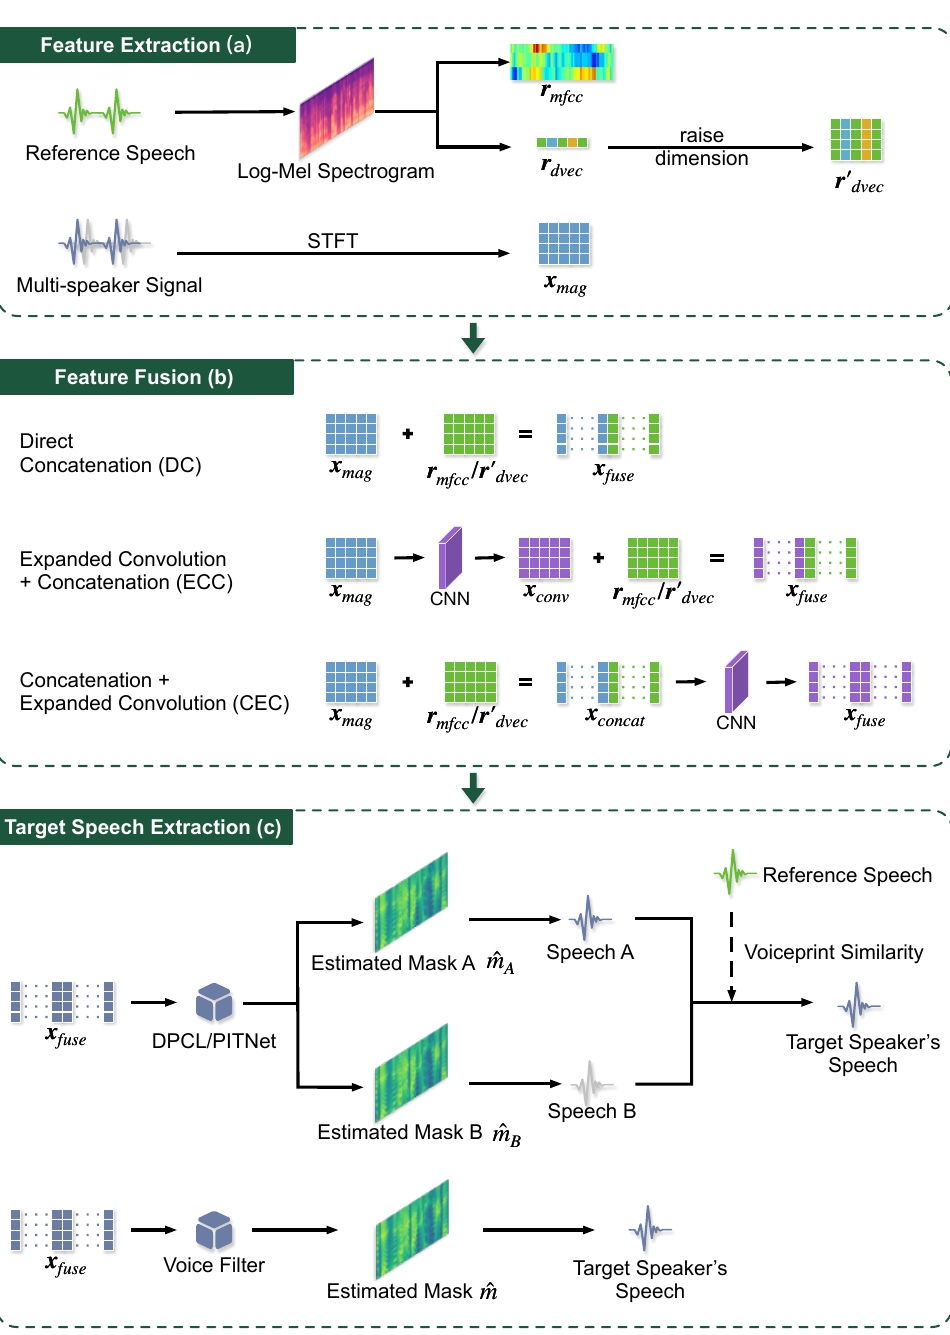
Figure 1. The workflow of Tse-FV model. ( a ) Feature extraction. MFCCs r mfcc and d-vectors r dvec are extracted from the reference speech. Magnitude spectrograms x mag are extracted from multispeaker signals. ( b ) Feature fusion. r mfcc and r dvec are concatenated in three ways, i.e., DC, ECC, and CEC, to construct the fused features x fuse . ( c ) Speech separation. Three models (DPCL, PITNet, and VoiceFilter) are adopted to generate the estimated magnitude spectral mask corresponding to the target speaker, and the masked magnitude spectrograms are transformed to clean speech using the inverse